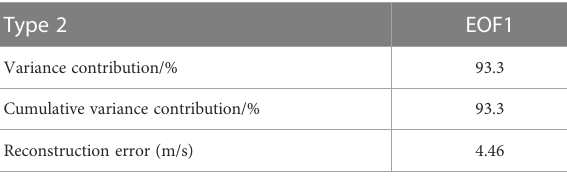
TABLE 3 First fi ve orders contribution rates and errors for Type